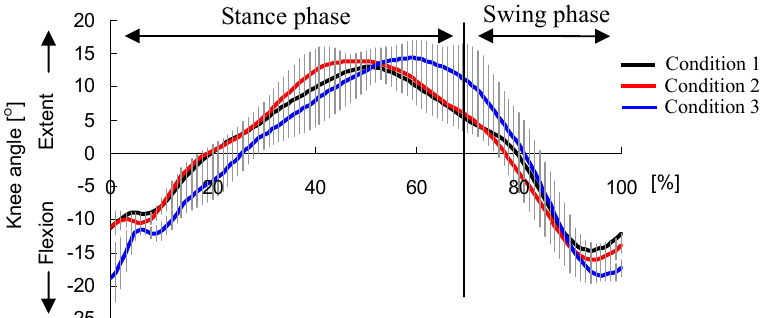
Fig. 9 Joint angle patterns of the affected side hip (mean value ± SD) drawn in the same manner as in Fig.